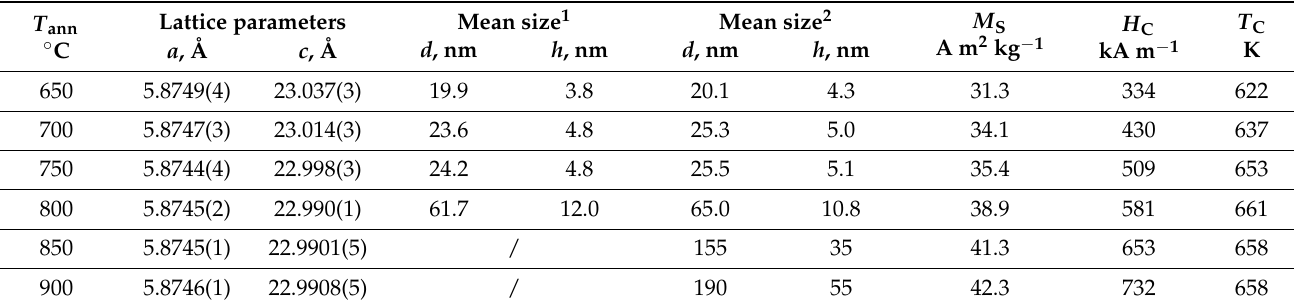
(Figure 3) with a lognormal distribution function ( d —diameter, h —thickness of the plate-like